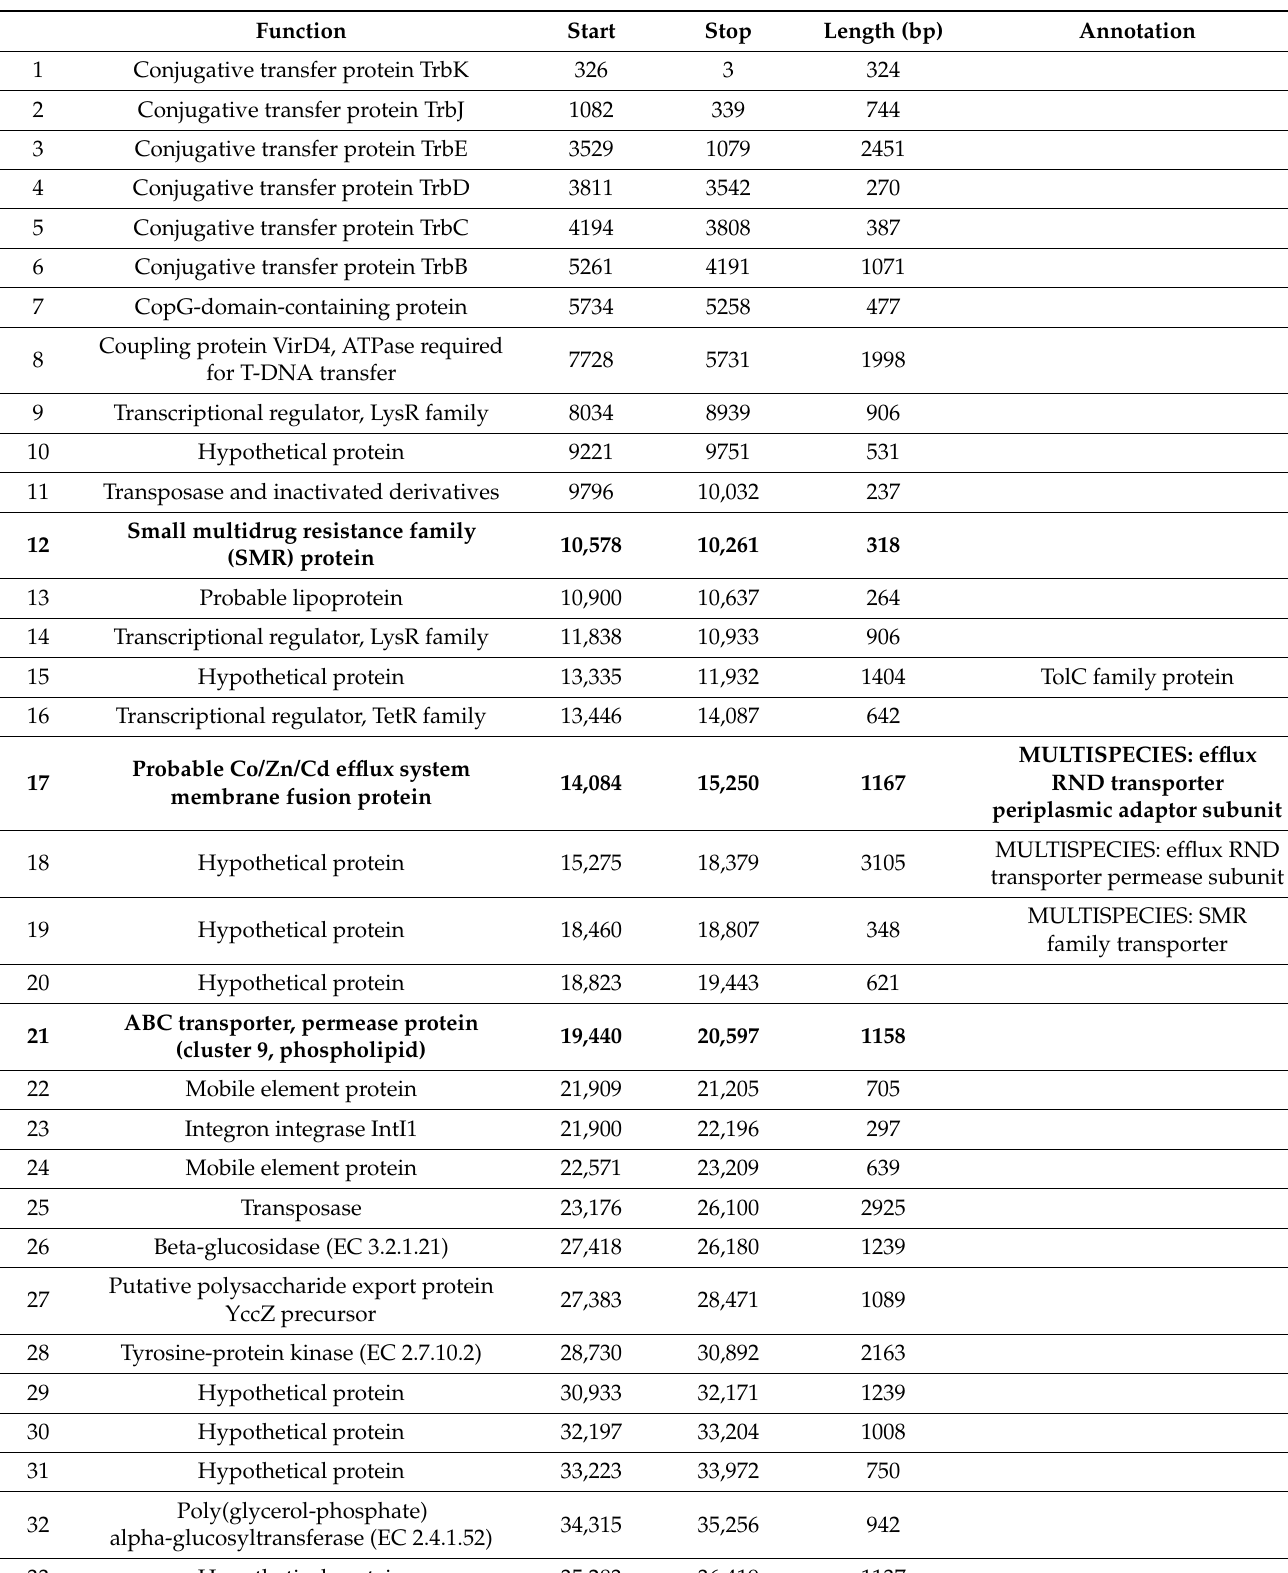
Table 3. Gene lists of genomic island 20 of Serratia sp. HRI (1 822 085 bp-1 869 515 bp, GC content 52.4, size 47 430 bp) identified via IslandViewer4. Gene function was annotated via RAST; any hypothetical or uncharacterised proteins were further analysed via NCBI PGAP and